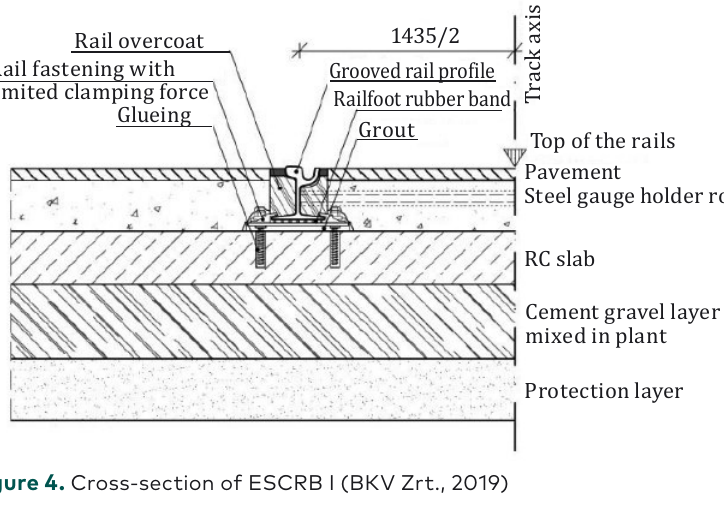
Figure 4. Cross-section of ESCRB I (BKV Zrt., 2019)